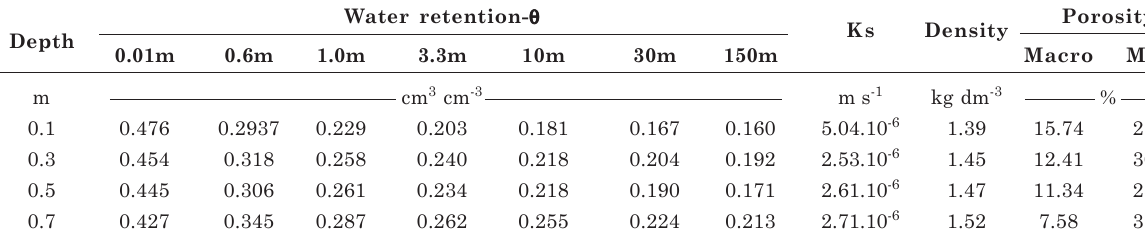
Ks: Saturated hydraulic conductivity